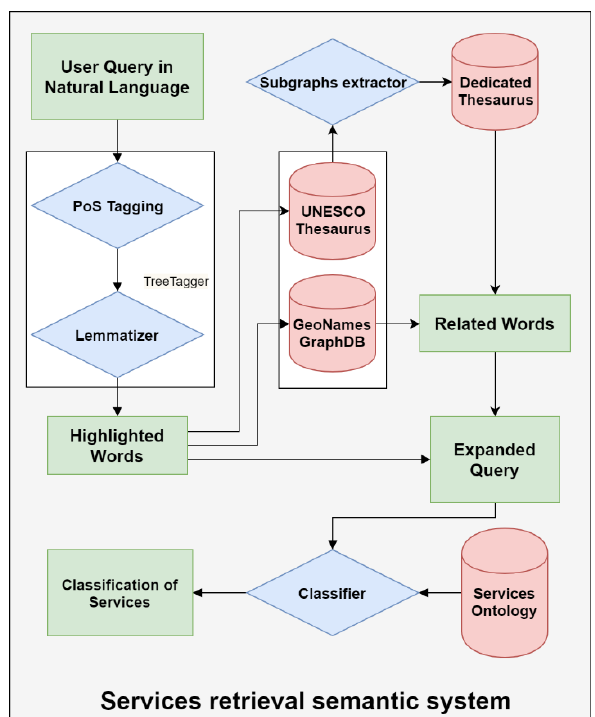
Figure 2. Schema of the workflow